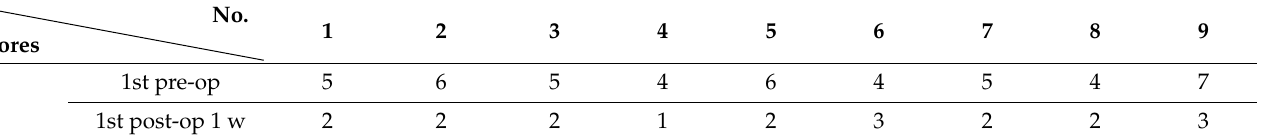
Table 1. Changes in VAS and ODI scores of recurrent pain in patients with